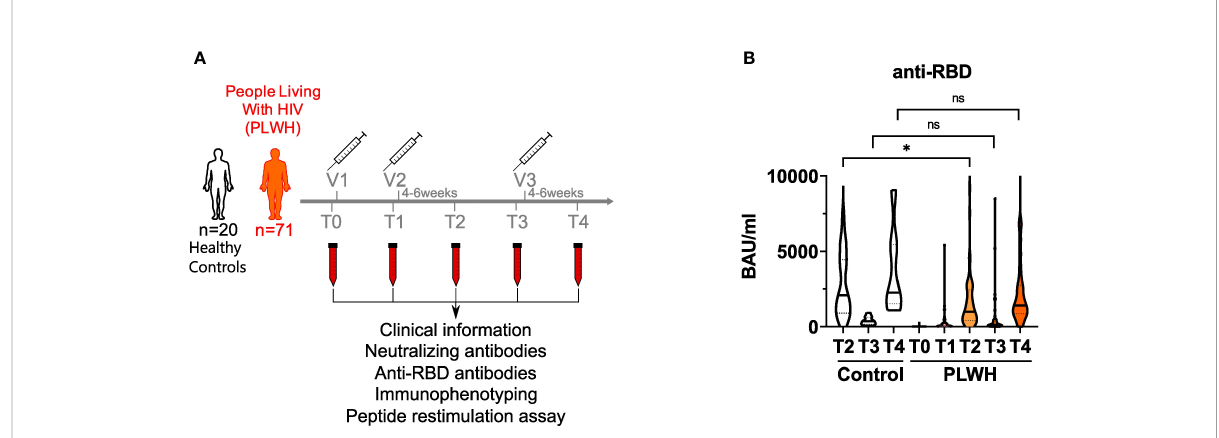
FIGURE 1 anti-RBD titers in vaccinated PLWH and HIV-negative controls. (A) Scheme showing the two groups of the study - control (n = 20) and people living with HIV (PLWH; n = 71) - and the time points of blood sampling (T0, T1, T2, T3 and T4) and vaccine inoculations (V1, V2, V3). (B) anti-RBD antibodies were determined by ELISA. Values are given as Binding Antibody Units (BAU) per ml. (PLWH T0, n = 71; PLWH T1, n = 61; PLWH T2, n = 68; PLWH T3, n = 47; PLWH T4, n=33; Control T2, n = 20; Control T3 & T4, n= 13). Statistical signi fi cance was calculated by two-tailed Welch´s test: *p < 0.05, ns, not signi fi cant.